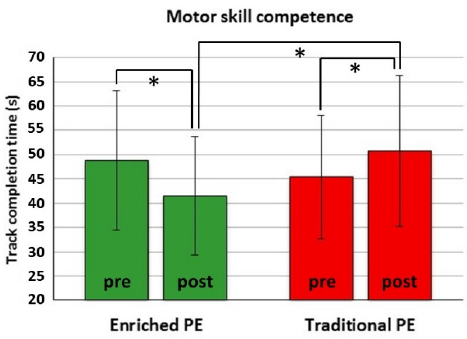
Figure 3. Completion time (s) of the Athletic Skill Track before (pre) and after (post) the actual enriched PE or traditional PE. * p < 0.016 (adjusted for three comparisons).